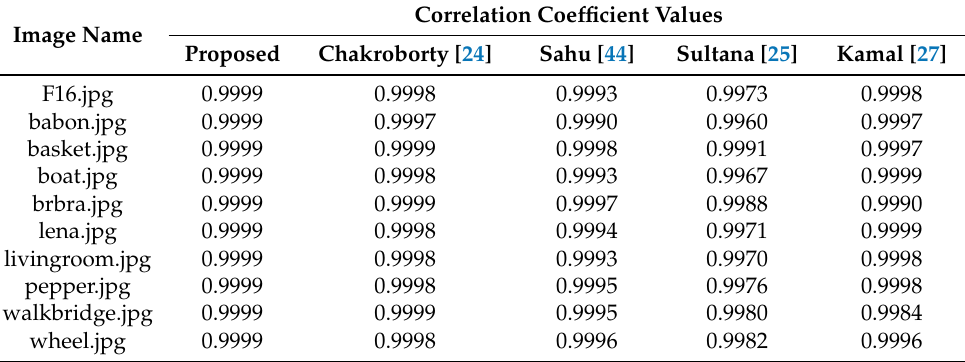
Table 1. Correlation coefficient values of various